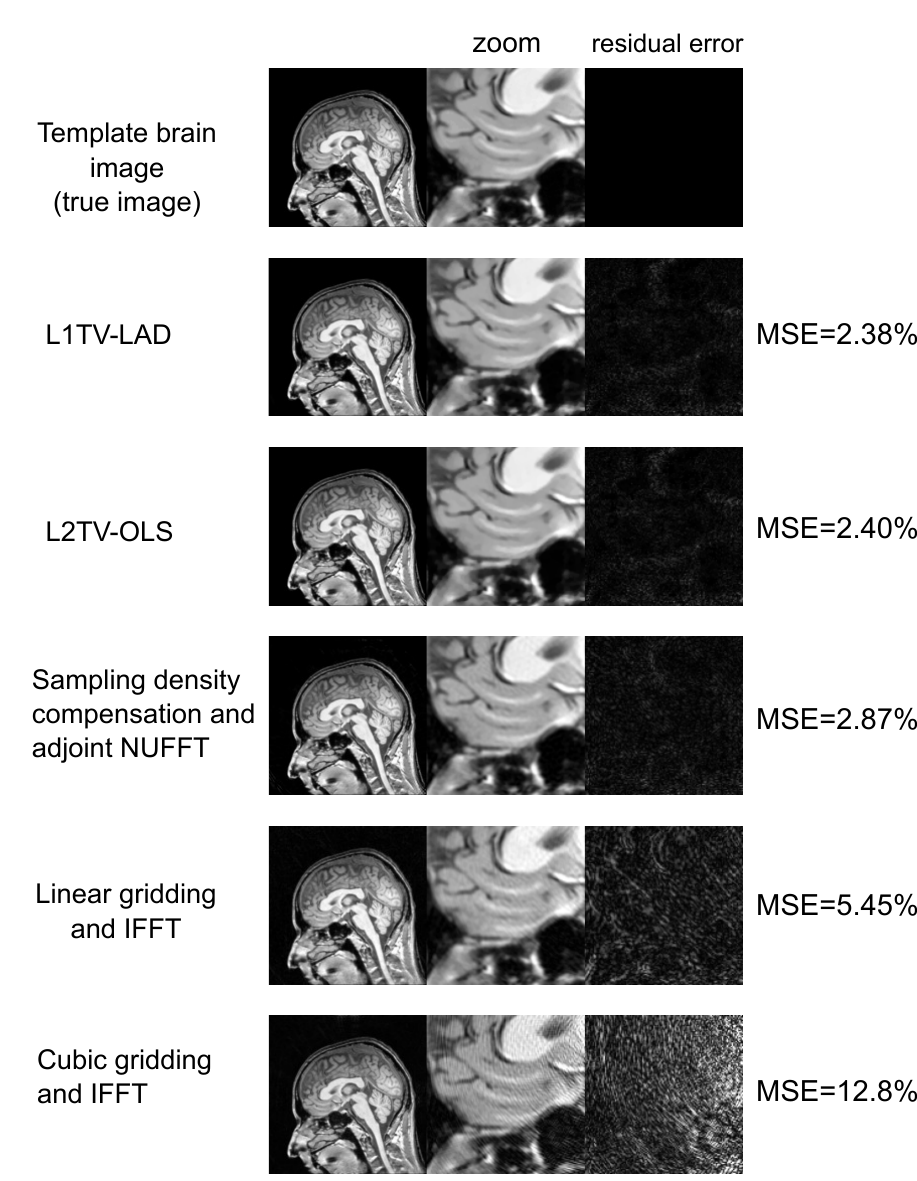
Figure 9. Simulated results of brain magnetic resonance imaging (MRI). A Periodically Rotated Overlapping ParallEL Lines with Enhanced Reconstruction (PROPELLER) k -space [22] was used in the simulated study. Matrix size = 512 × 512, oversampled ratio = 2, kernel size = 6, maximum iteration number = 500. The brain template was reconstructed with L1TV-OLS and L1TV-LAD, the sampling density compensation method, and two gridding-based IFFT methods. Compared with sampling density compensation method, fewer ripples can be seen in L1TV-OLS and L1TV-LAD. The conventional IFFT combined with two gridding methods caused a greater MSE than the iterative NUFFT